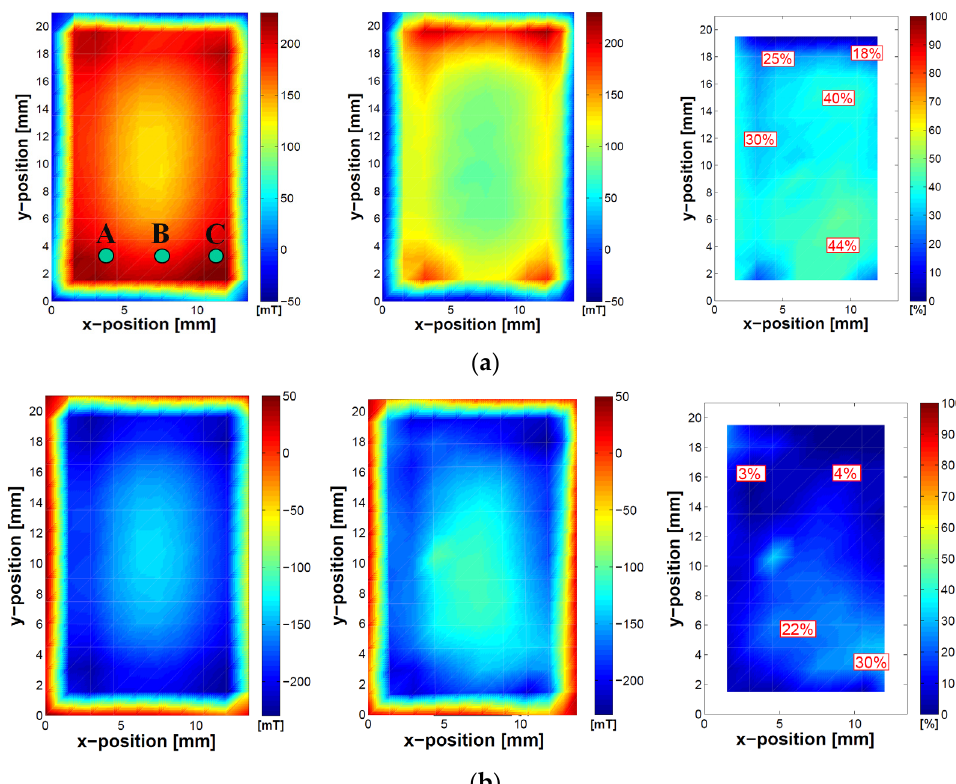
Figure 12. Comparison of measured surface flux density of the same magnets in air before (left) and after (middle) the locked-rotor test with 20 A current pulse at 100 degC and the reduction (in %) of surface flux density after the locked-rotor test (right): ( a ) north pole; ( b ) south pole. Three measurement points are marked in the north pole magnet (left).